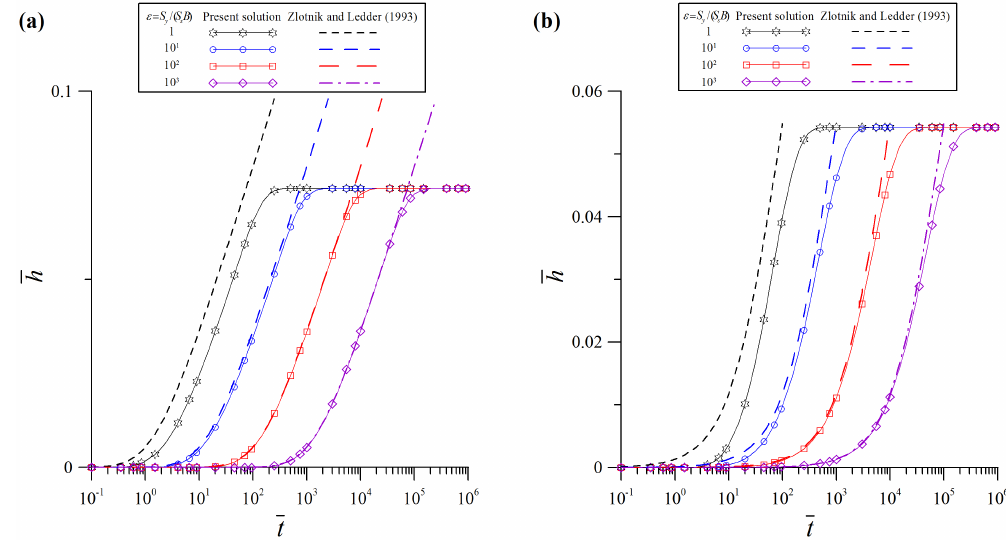
Figure 4. Temporal distributions of the dimensionless head for (a) κ z = 10 and (b) κ z = 10 − 2 predicted by the Zlotnik and Ledder (1993) solution based on the assumption of S s = 0 and the present solution relaxing the assumption.